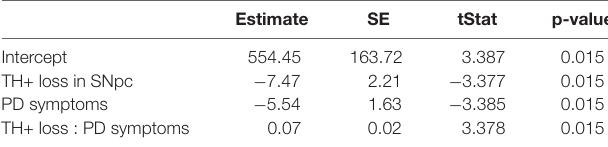
TABLE 2 | Estimated coefficients of the linear regression model. Estimate SE tStat